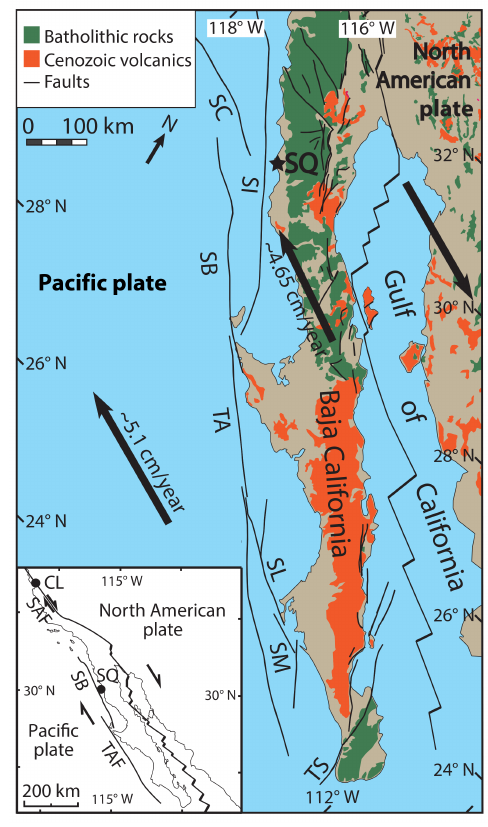
Figure 1. Geological map of Baja California, Mexico, showing the location of the San Quintín volcanic field (SQ) (modified af- ter Langenheim and Jachens, 2003). The San Clemente (SC), San Isidro (SI), San Benito (SB), Tosco-Abreojos (TA), San Lazaro (SL), Santa Margarita (SM), and Todos Santos (TS) faults comprise parts of the Baja California shear zone. Arrows indicate the relative movement of the Pacific plate and the Baja California microplate with that of the North American plate (Plattner et al., 2007). Inset is a tectonic map of the Pacific–North American plate boundary, showing the location of the Baja California shear zone and the San Quintín volcanic field relative to the San Andreas fault (SAF) and the Coyote Lake volcanic field